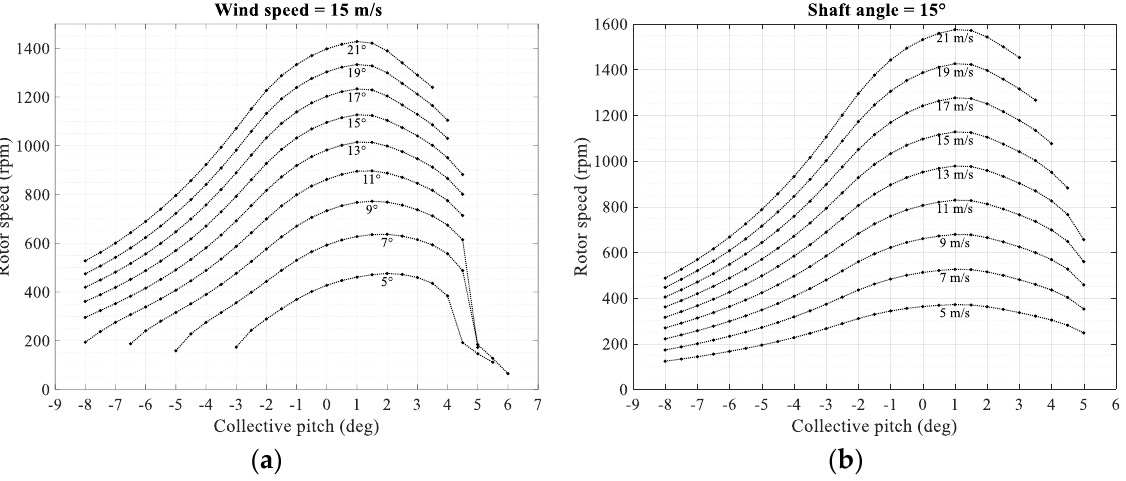
Figure 9. Rotor speed of steady autorotation at ( a ) V 5 m/s ≤ V x ≤ 21